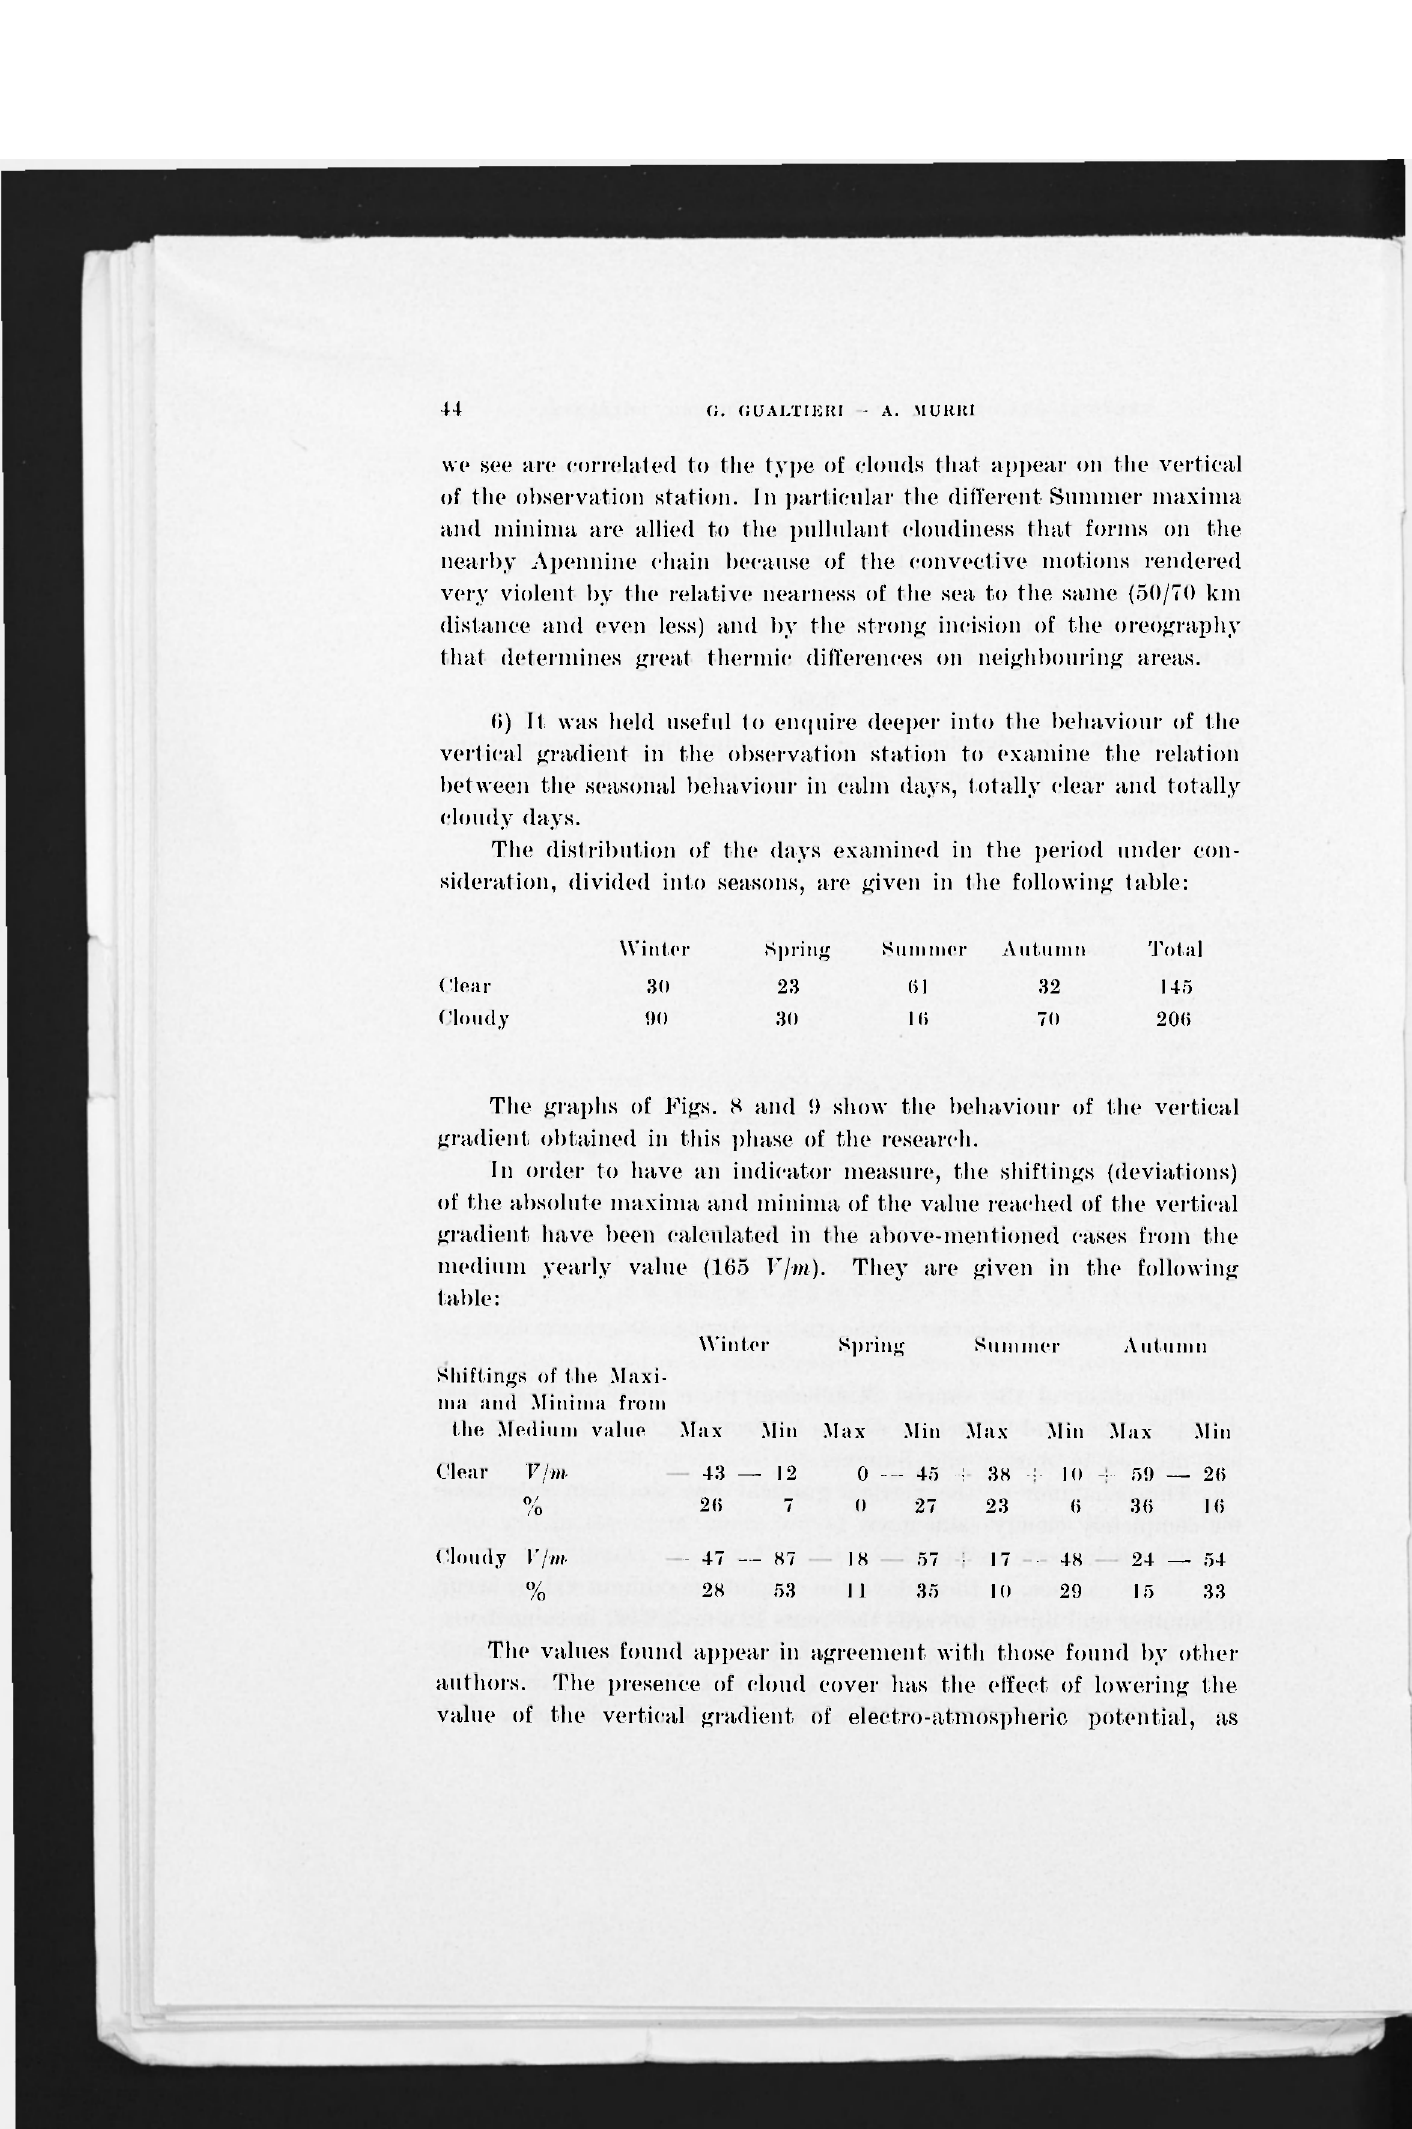
Shifting« of the .Maxi- ma and Minima from the Medium